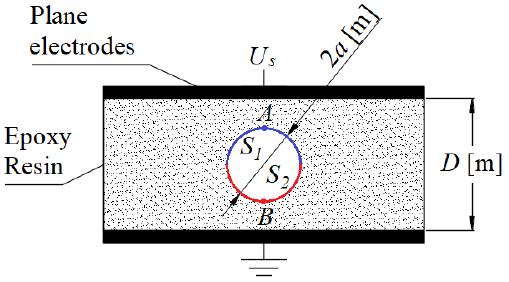
Figure 1. Geometry of the case studies. Material specifications, applied voltage and dimension magnitudes presented in Table 1.